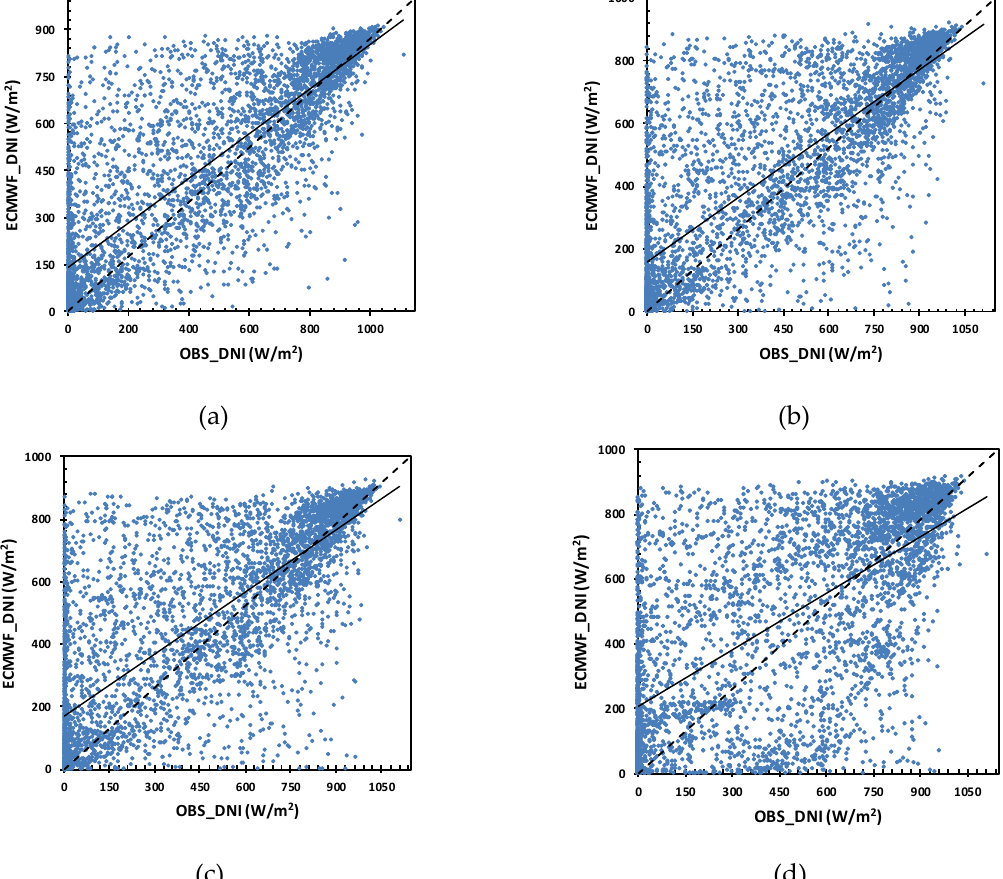
Figure 3. Scatter plots of predicted vs. measured hourly mean DNI for: ( a ) day_0, ( b ) day_1, ( c ) day_2, and ( d ) day_3, during the entire period considered. The dashed line represents the y = x line and the solid line is the least-squares regression fit.